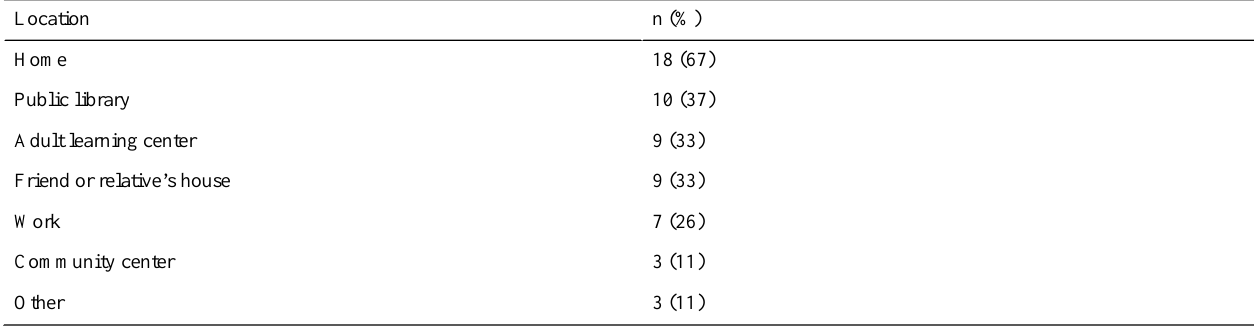
Table 5. Location of computer use (n=27 a ).